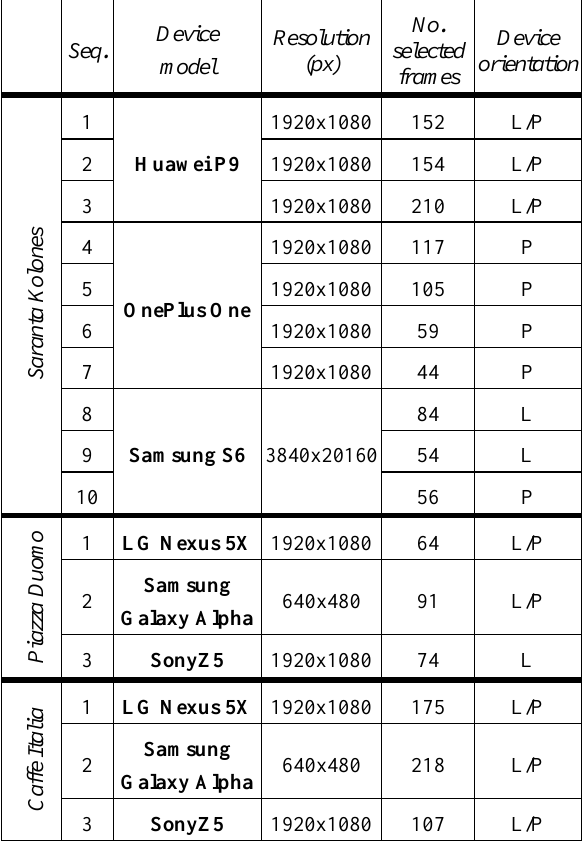
Table 1. Main characteristics of the employed datasets. L stands for landscape and P for